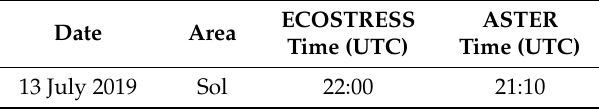
Table 3. ECOSTRESS and ASTER data close in